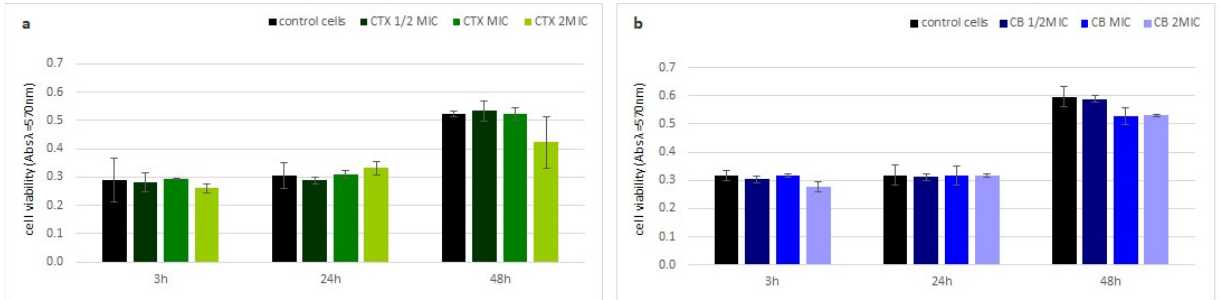
Figure 4. Toxin cytotoxicity on human cells. Time dependent fraction of viable human fibroblast cells (HDF) after incubation with ( a ) crotoxin and ( b ) the CB subunit relative to non-treated cells using the MTT test. Error bars represent the standard deviation of three replicates.